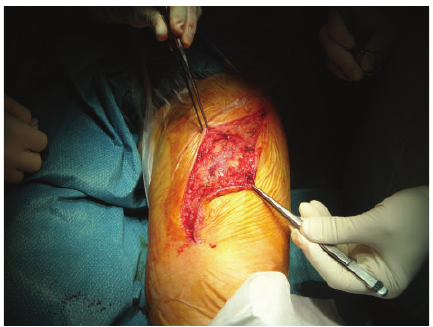
Figure 4: Anterior thigh S shaped incision.